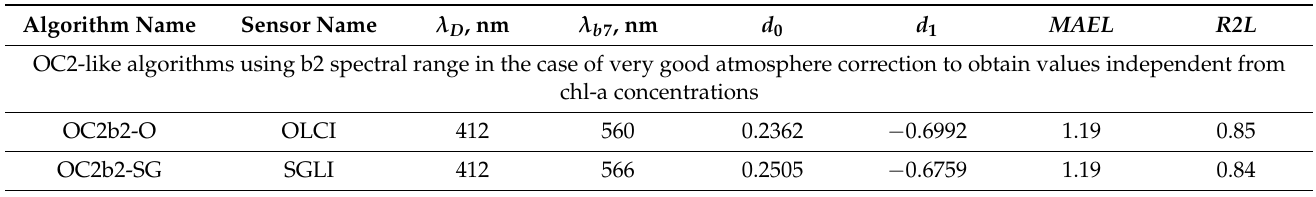
Table 9. Set of satellite regional bio-optical algorithms for the estimation of CDOM content in QSU